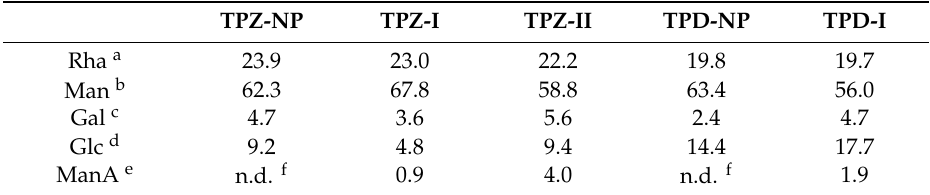
Table 3. The monosaccharide compositions (mol%) of polysaccharide fractions isolated from T. panzhihuanense and T.